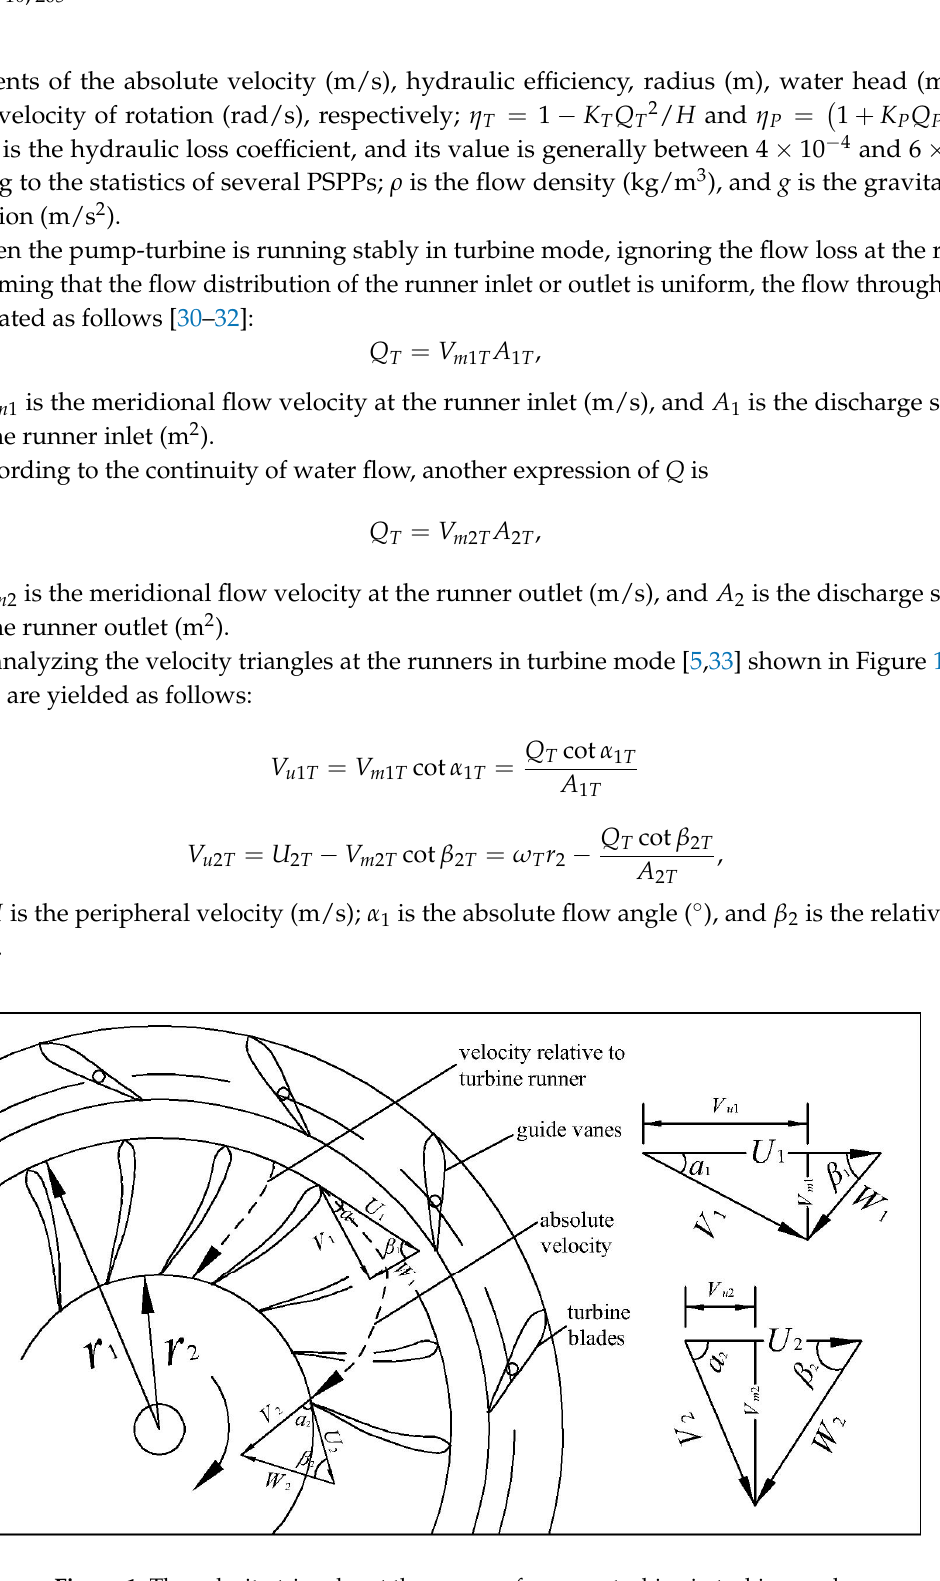
Figure 1. The velocity triangles at the runner of a pump-turbine in turbine mode.